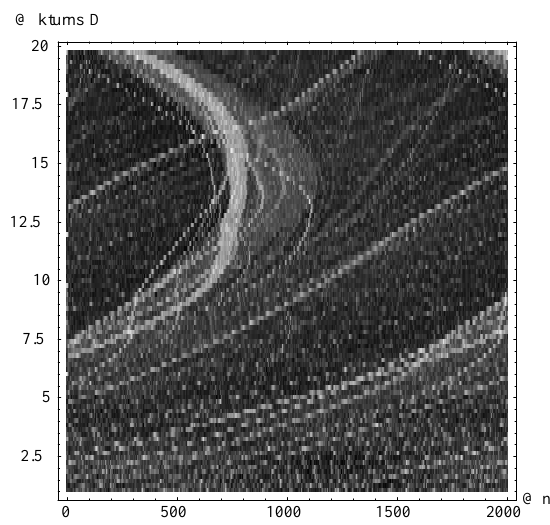
FIG. 2. 3.6 3 10 12 protons, one trace each 200 turns, vertical span 31.7